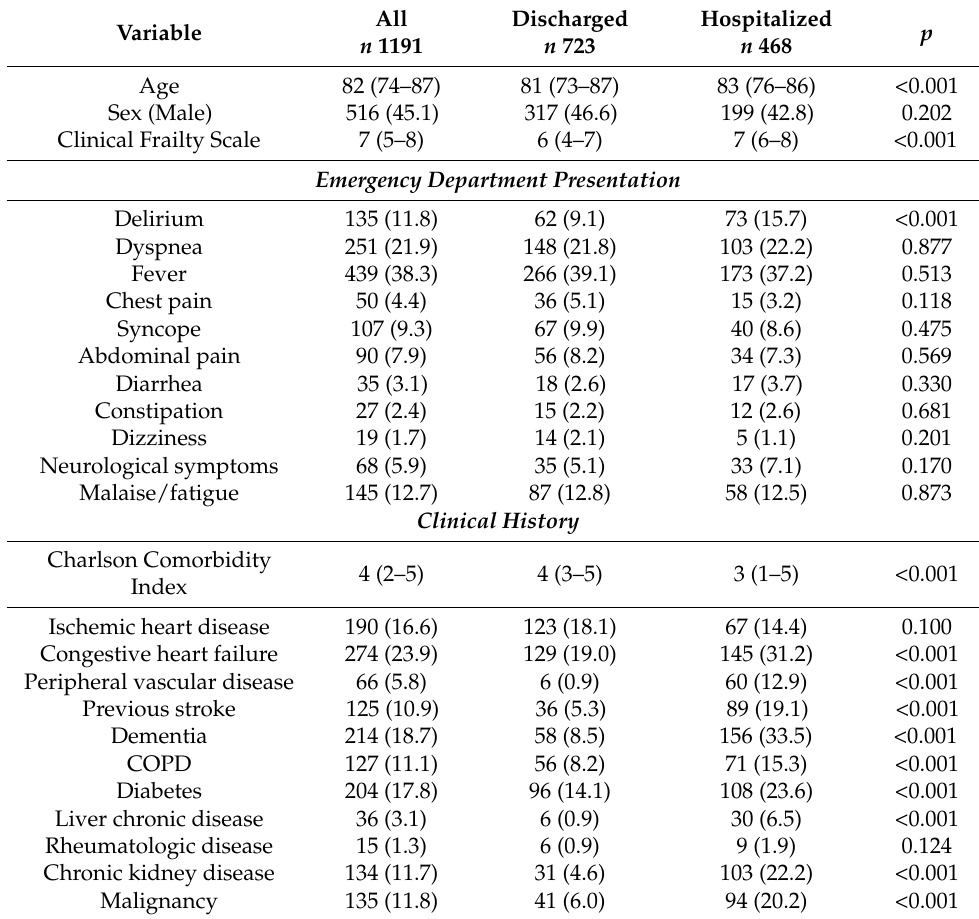
Table 1. Population demographics of patients admitted to the Emergency Department and evaluated by the Frailty Unit. Comparison of discharged and hospitalized